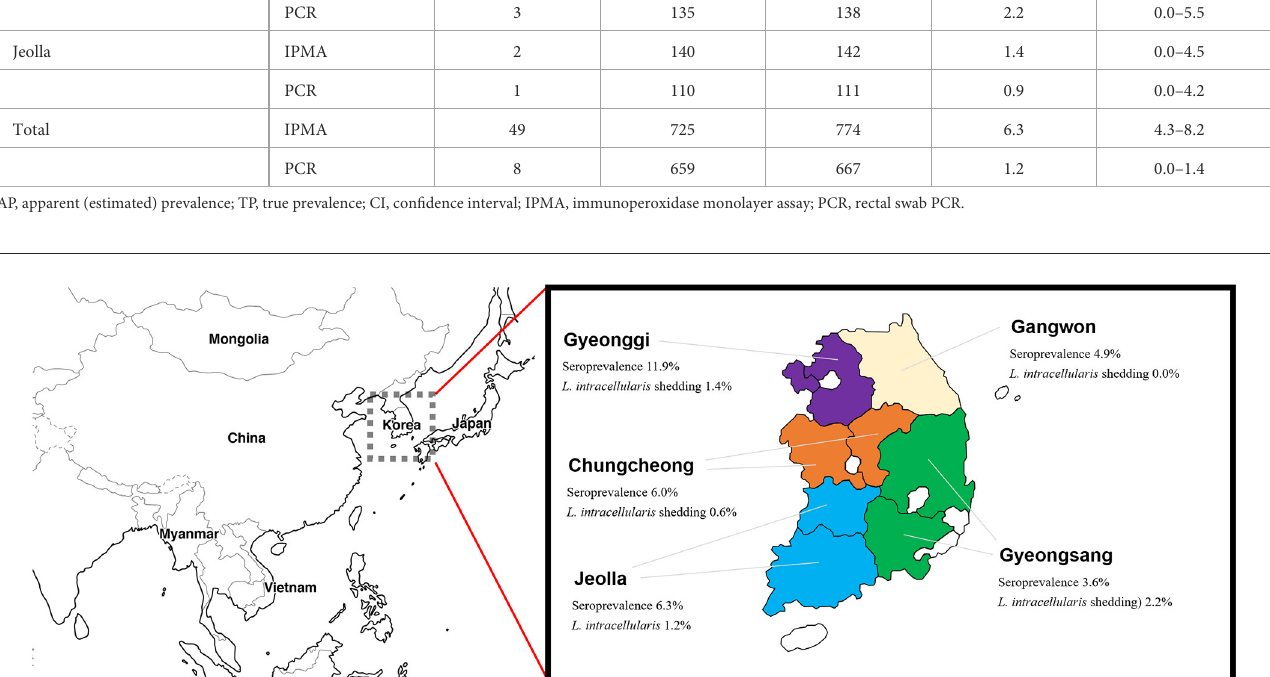
positive (DNA from cell-grown L. intracellularis ) and negative (